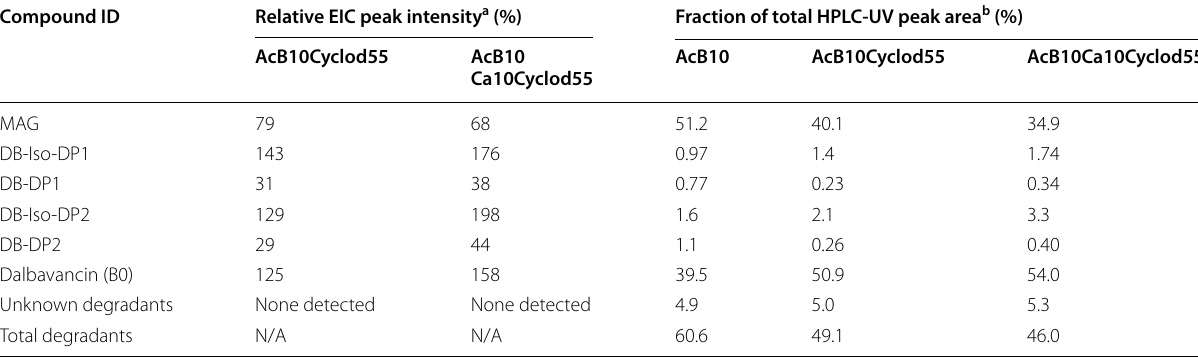
a Levels of degradation products are expressed relative to their levels in acetate buffer without metal ions b Levels of degradation products are expressed as the area under their HPLC peak as a percentage of the total peak area